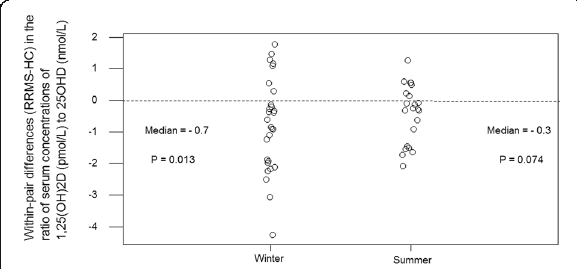
Fig. 4 Within-pair differences (RRMS-HC) in the serum 1,25(OH) 2 D to 25OHD